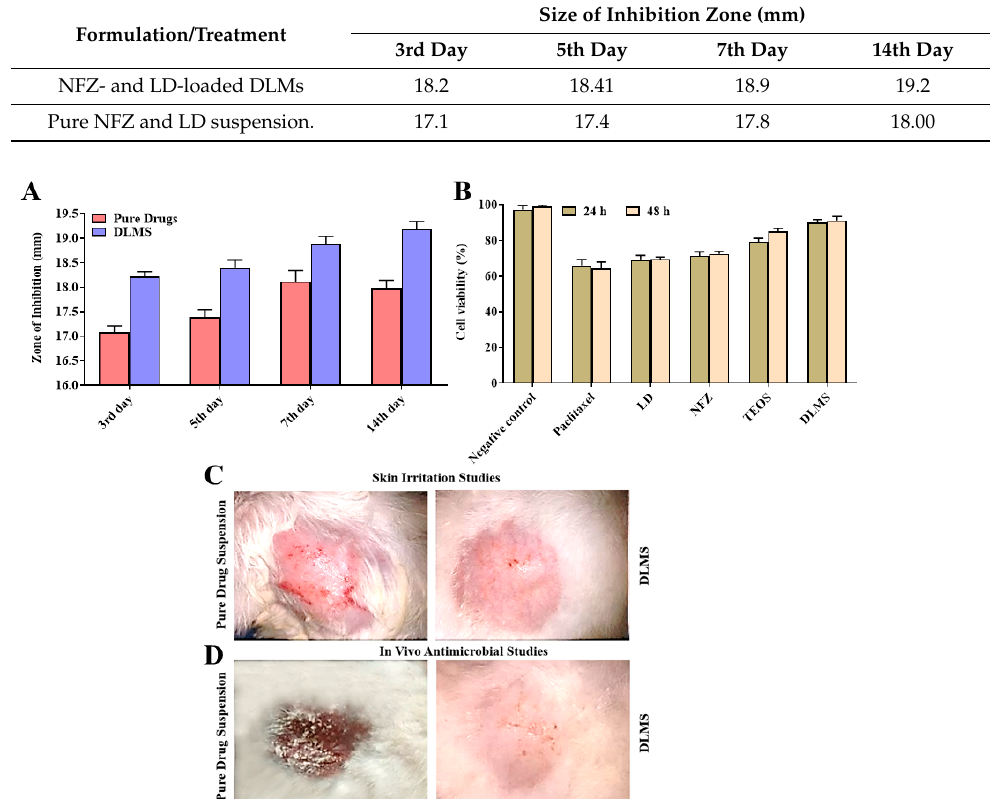
Figure 5. In vitro antibacterial studies demonstrating comparative zone of inhibition ( A ); cytotoxicity studies of NFZ, LD and DLMs ( B ); skin texture images of rabbits obtained at day 14 during skin irritation studies ( C ) [in vivo antimicrobial studies ( D ) for the pure drug suspension treated group and drug-loaded silica microspheres. The values are mean ± SE of three independent experiments. Table 3. A comparison of in vitro antibacterial analysis of DLMs and pure drugs.